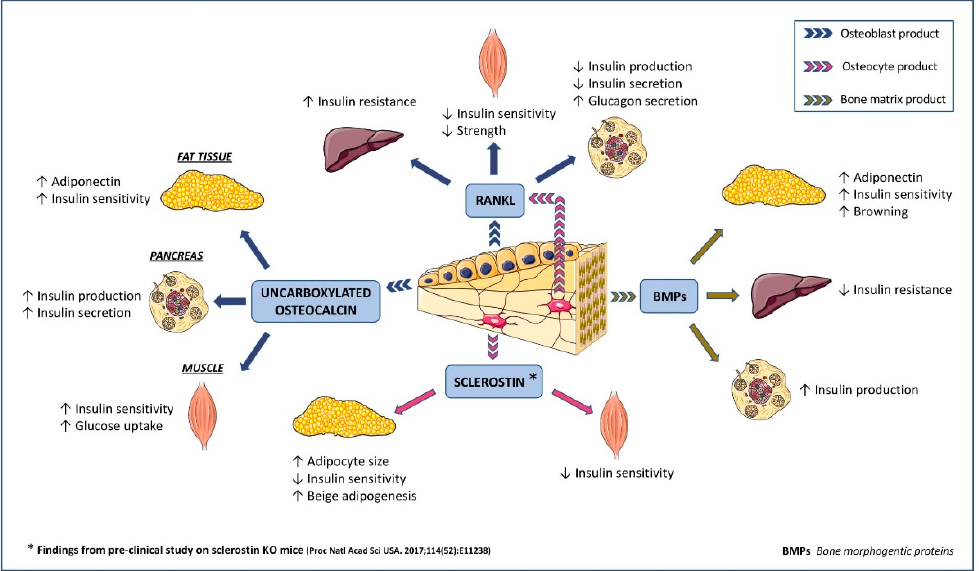
Figure 1. Potential action of main osteokines on glucose homeostasis (see text for References) .